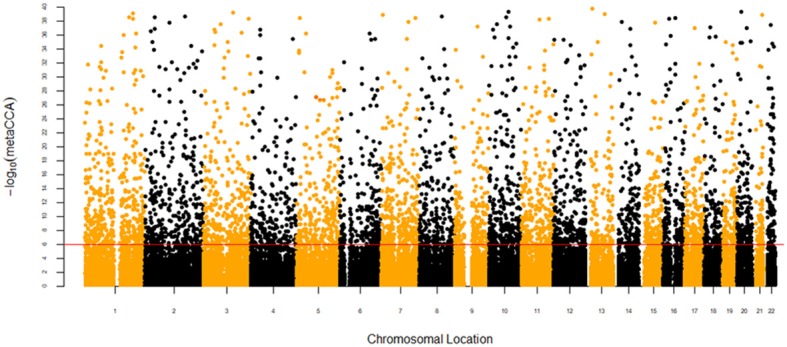
Manhattan plot of –log10(metaCCA) values for univariate SNP-seven autoimmune/autoinflammatory diseases analysis. The red line marks the –log10(metaCCA) value of 5.92 corresponding to P < 1.21 × 10−6. If the –log10(metaCCA) value of a certain SNP was >5.92, this SNP was identified as a pleiotropic SNP for seven diseases.